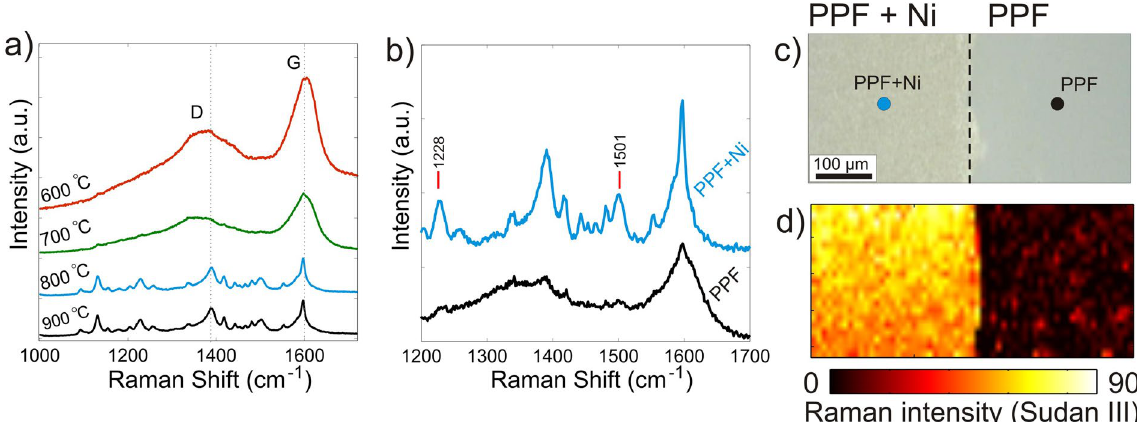
Figure 4. GERS spectra of Sudan III molecule. ( a ) The PPF + Ni process temperature dependence to the resulting GERS enhancement shows remarkable difference between sample fabricated at 700 °C and 800 °C. ( b ) Raman spectra for the PPF + Ni and PPF fabricated at 800 °C (averaged over the substrate surface). ( c ) Optical microscope image showing the boundary between PPF + Ni and PPF. ( d ) Mapping of the Sudan III Raman peak at 1228 cm − 1 at the boundary between PPF + Ni and PPF substrates. In both ( a and b ) the spectra have been displaced for